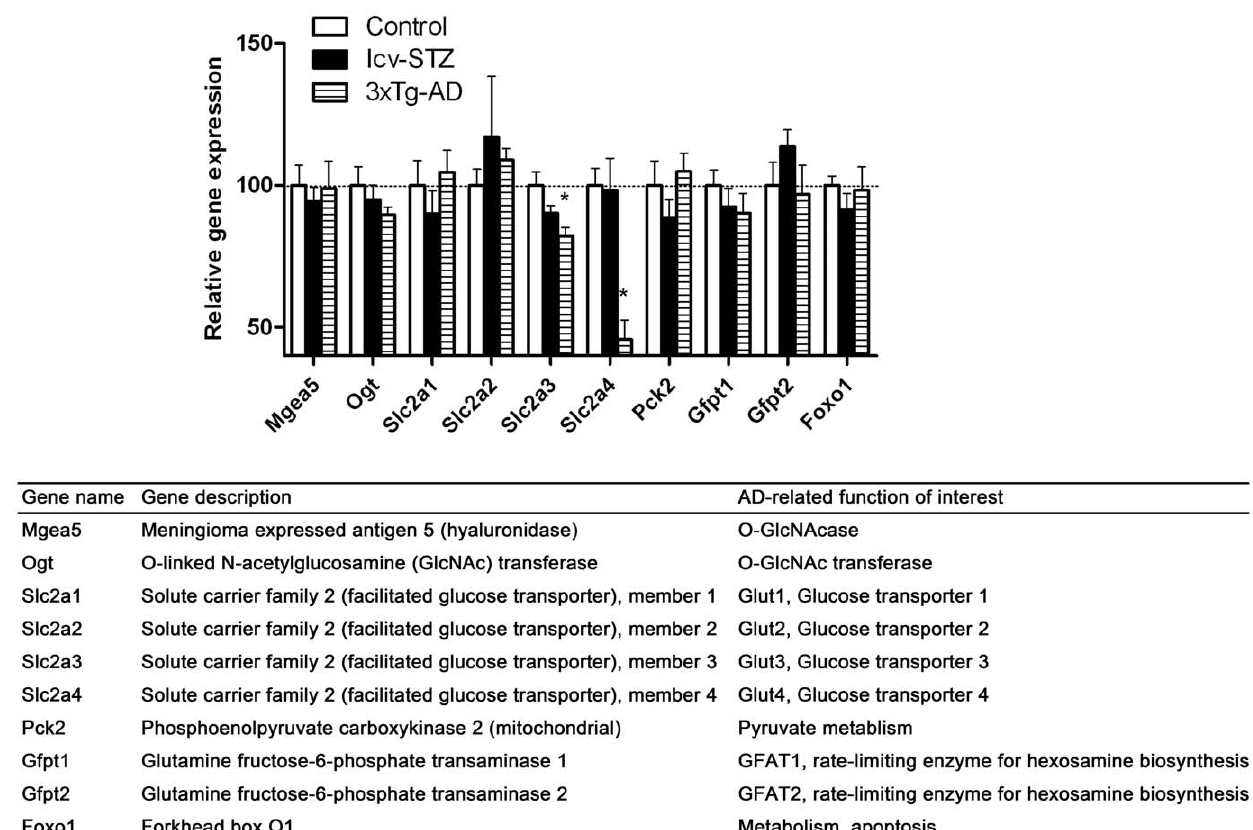
Figure 7. Glucose metabolism–related gene expressions in the hippocampus.